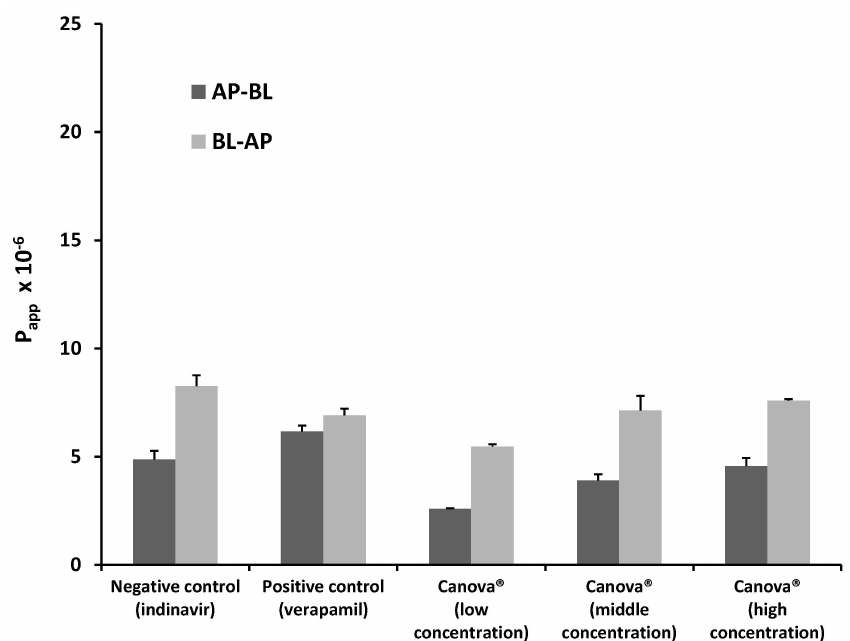
Figure 3. Bi-directional P app values for indinavir in the presence of three concentrations of Canova ® as well as for the negative control group (indinavir alone) and positive control group (indinavir with verapamil). n = 3 , error bars indicate standard